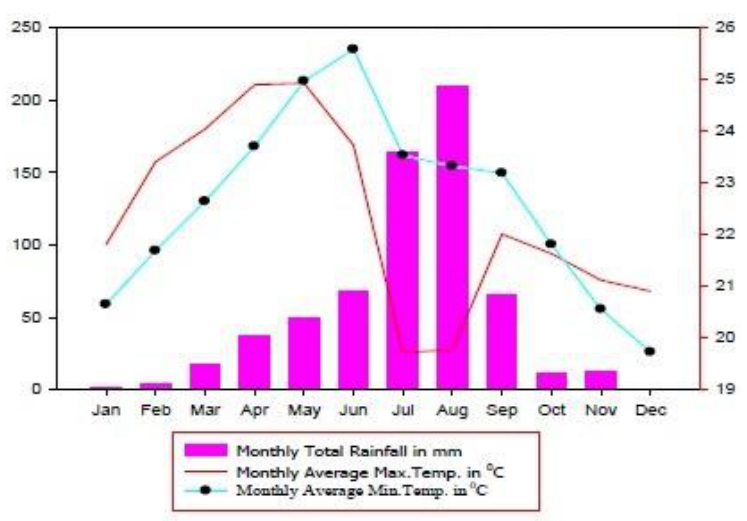
Figure 2. Monthly total rain fall and average maximum and minimum temperatures of the study area (2002–2015).